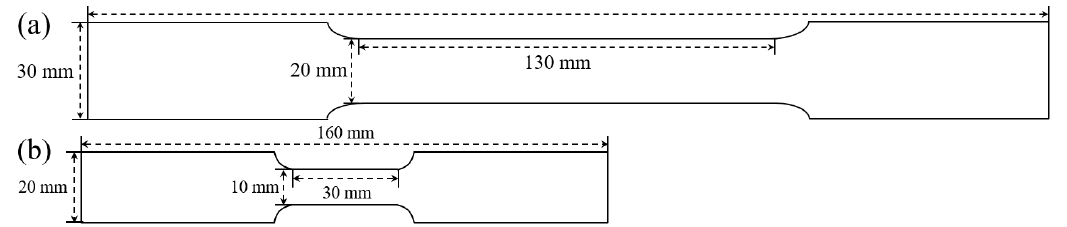
Figure 1. The geometry of ( a ) quasi-static and ( b ) dynamic tensile specimens.